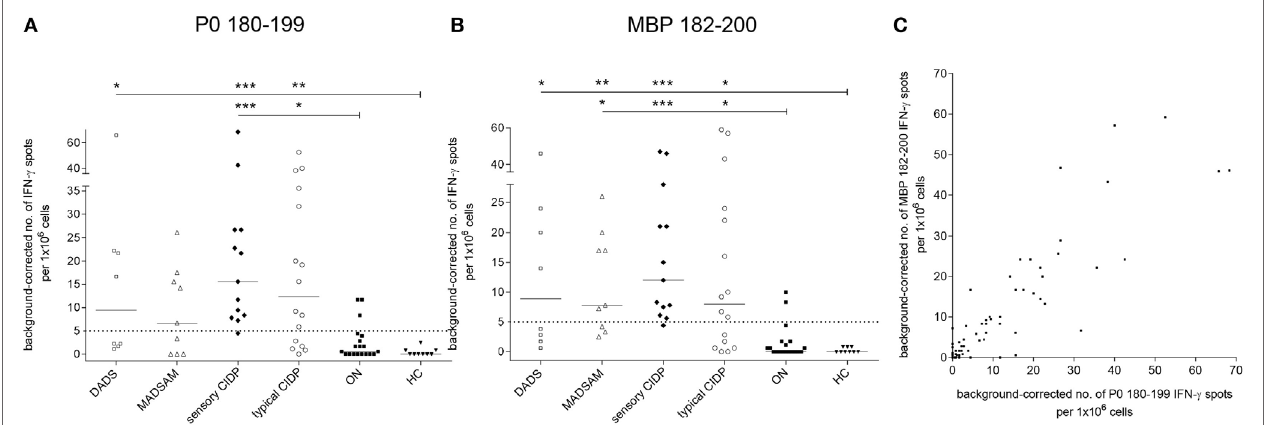
FigUre 2 | Compact myelin-specific T cell responses are elevated in chronic inflammatory demyelinating polyneuropathy (CIDP) subtypes compared to controls. Frequency of peripheral antigen-specific T cell responses in patients with demyelinating polyneuropathy (DADS) ( n = 8), multifocal acquired demyelinating sensory and motor polyneuropathy (MADSAM) ( n = 9), sensory CIDP ( n = 13), typical CIDP ( n = 16), other non-immune polyneuropathy (ON) ( n = 19), and healthy control (HC) ( n = 9) measured by enzyme-linked immunospot assay. Lines at median. Background corrected interferon-gamma (IFN- γ ) spot forming cells per 1 × 10 6 peripheral blood monocytes against myelin protein zero (P0) 180–199 (a) and myelin basic protein (MBP) 82–100 (B) (*** p < 0.001, ** p < 0.01, * p < 0.05; Dunn’s multiple comparisons test). (a) Cutoff was defined at spot forming unit (SFU) ≥ 5 with sensitivity of 92.3% and specificity of 84.2%, based on receiver operating characteristics (ROC) analysis comparing sensory CIDP and ON [area under the ROC curve (AUC) = 0.94 with 95% confidence interval of 0.86–1]. (B) Cutoff was defined at SFU ≥ 5 with sensitivity of 92.3% and specificity of 89.5% based on ROC analysis comparing sensory CIDP and ON (AUC = 0.95 with 95% confidence interval of 0.88–1). (c) IFN- γ reaction to MBP in correlation to P0 as measured by Spearman correlation with r = 0.82 ( p <